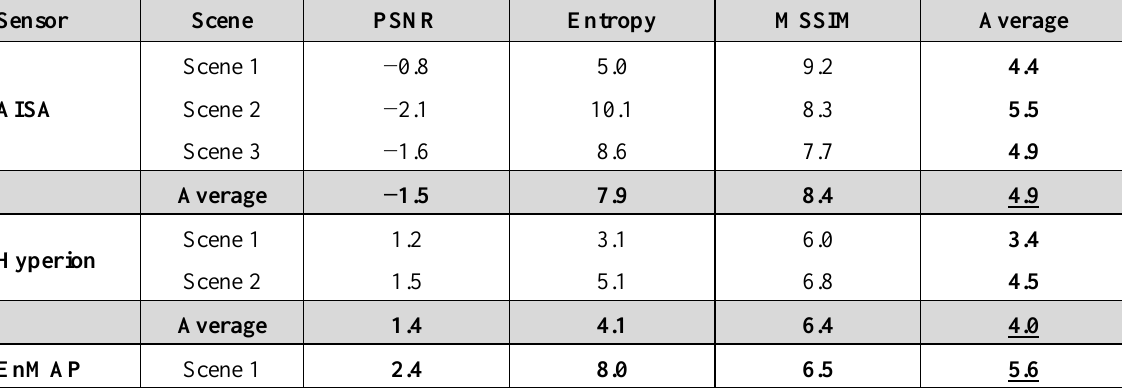
Table 3. Image quality indices for destriped hyperspectral scenes as rate of change [%].